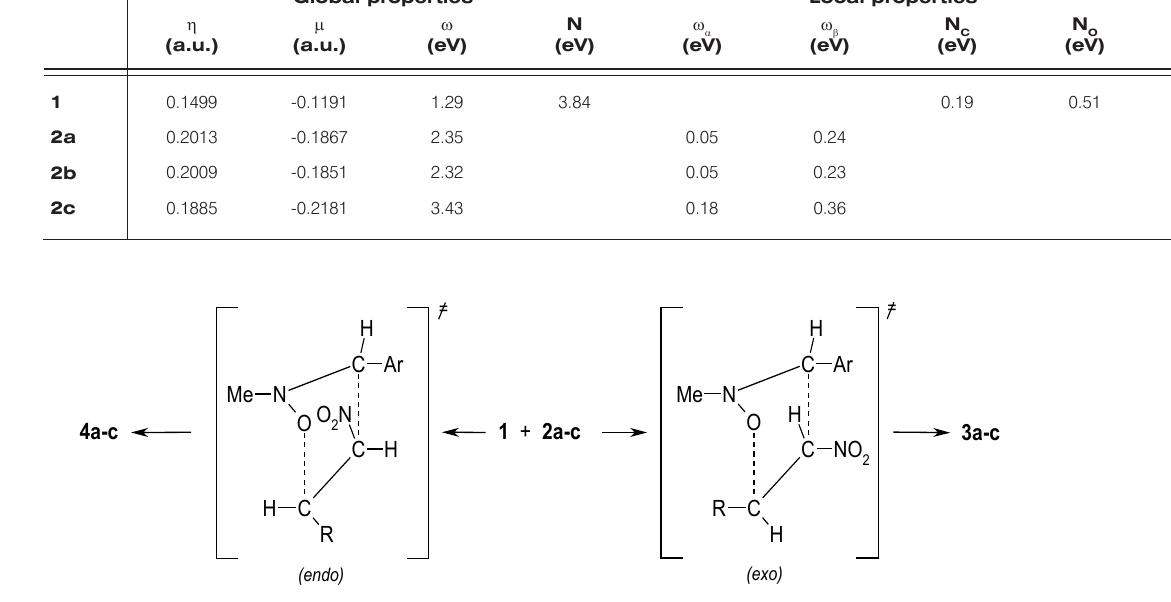
Figure 1. Transition complexes trajectories for formation of the stereoisomeric